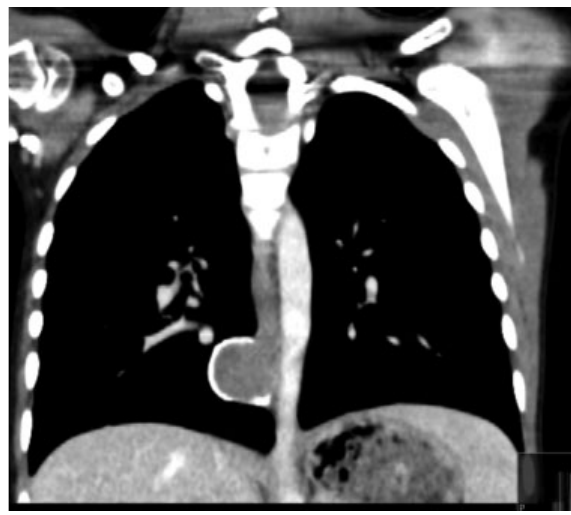
Fig. 2 Computed tomography